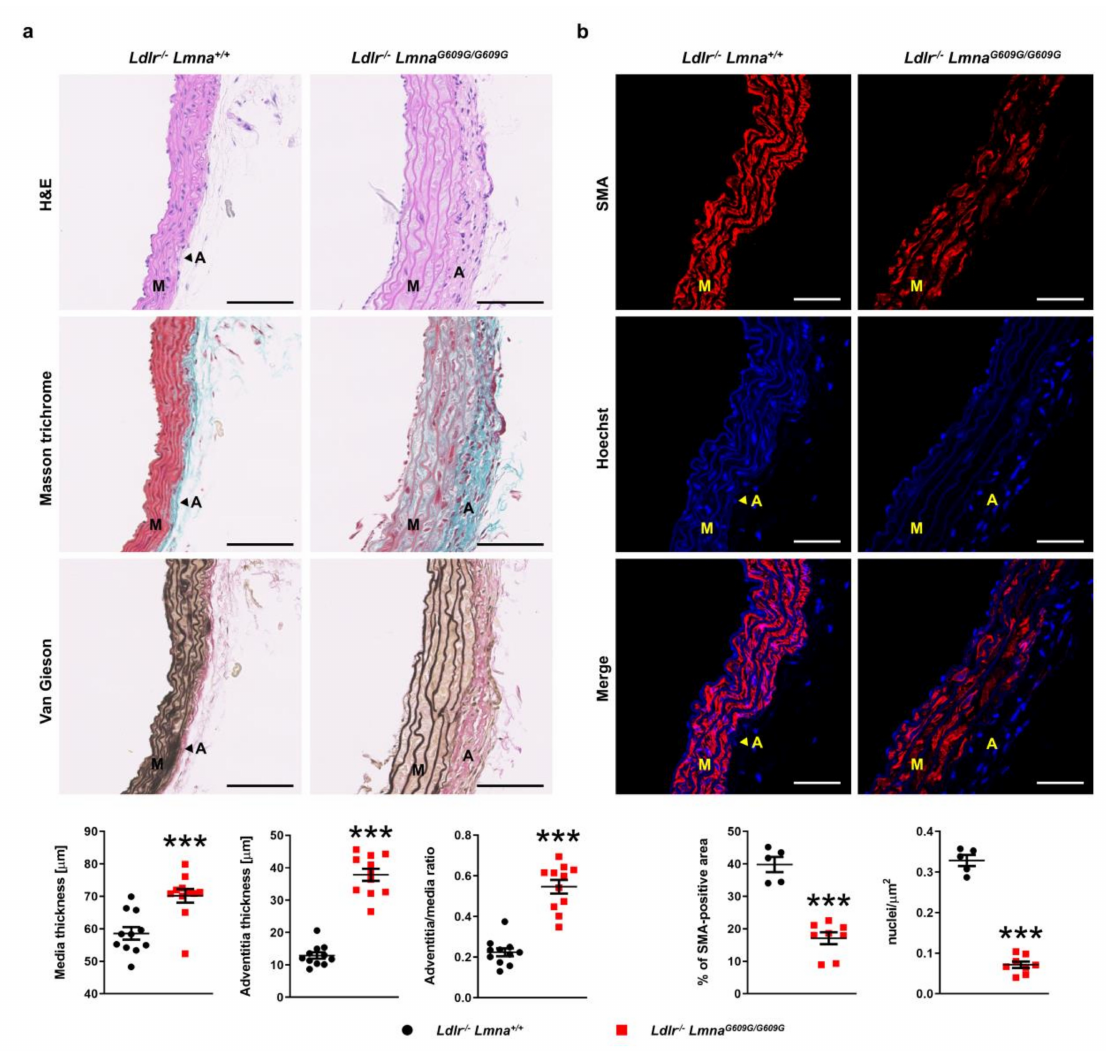
Figure 5. Pathological changes in the aortic wall of fat-fed male Ldlr − / − Lmna G609G / G609G mice. Male mice were fed a high-fat diet from eight weeks of age and sacrificed at 16 weeks of age. ( a ) Representative images of aortic arch sections stained with hematoxylin–eosin (H&E), Masson trichrome, and Van Gieson stain. Scale bar, 100 µ m. Graphs show medial and adventitial thickness and the adventitia-to-media ratio in Ldlr − / − Lmna +/+ mice( n = 11)and Ldlr − / − Lmna G609G / G609G mice( n = 11). ( b )Representativefluorescence images of aortic arch sections stained with an anti- α -smooth muscle actin (SMA) antibody (red) and Hoechst 33342 nuclear dye (blue). Scale bar, 50 µ m. Graphs show the percentage of SMA-positive area and nuclei count / area in the media of Ldlr − / − Lmna +/+ mice ( n = 5) and Ldlr − / − Lmna G609G / G609G mice ( n = 8). Data are presented as mean ± SEM. Each point represents the mean for three aortic arch sections per mouse. Statistical analysis was performed by two-tailed t -test with Welch’s correction in ( a ) and by two-tailed t -test in ( b ). ***, p < 0.001. M, media; A,